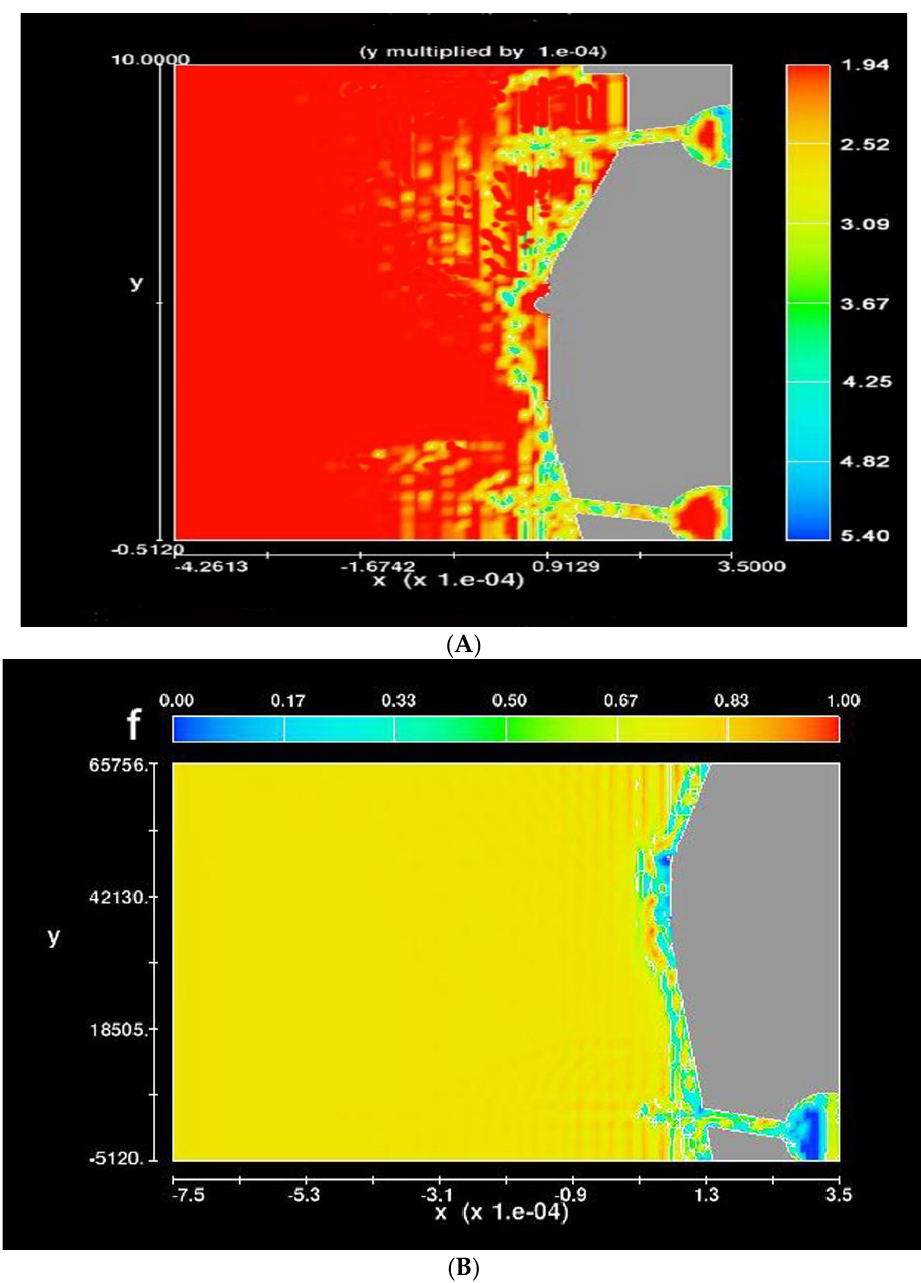
Figure 29. ( A ) Offshore slurry deposition density from an El Niño flood event from CFD calculations for a low offshore benthic slope. Scale density in slugs/ft 3 (1 slug/ft 3 = 515.38 kg/m 3 ) representative of slurry mixtures with high rock content. Result from [2], p. 246. ( B ) Offshore slurry deposition fluid fraction density from an El Niño flood event from CFD calculations for steep benthic slope typical of the Supe Valley offshore region. Result from [2], p. 248 (1 slug/ft 3 = 515.38 kg/m 3 ).